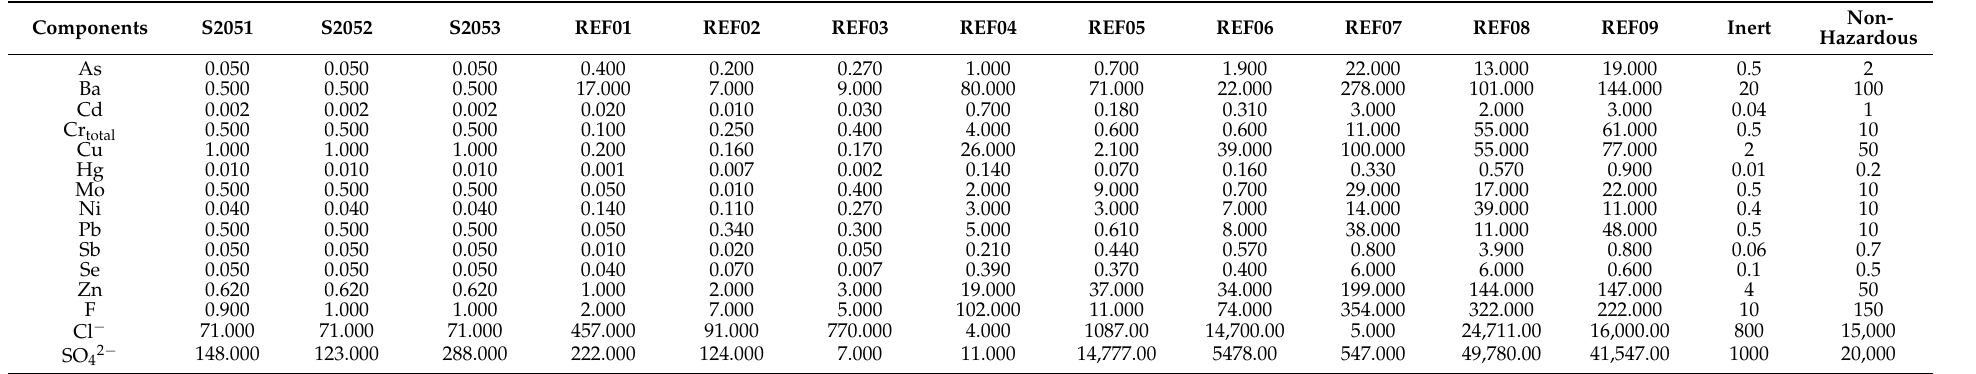
Table 2. Samples ( n = 12) of spent refractories, along with inert and hazardous